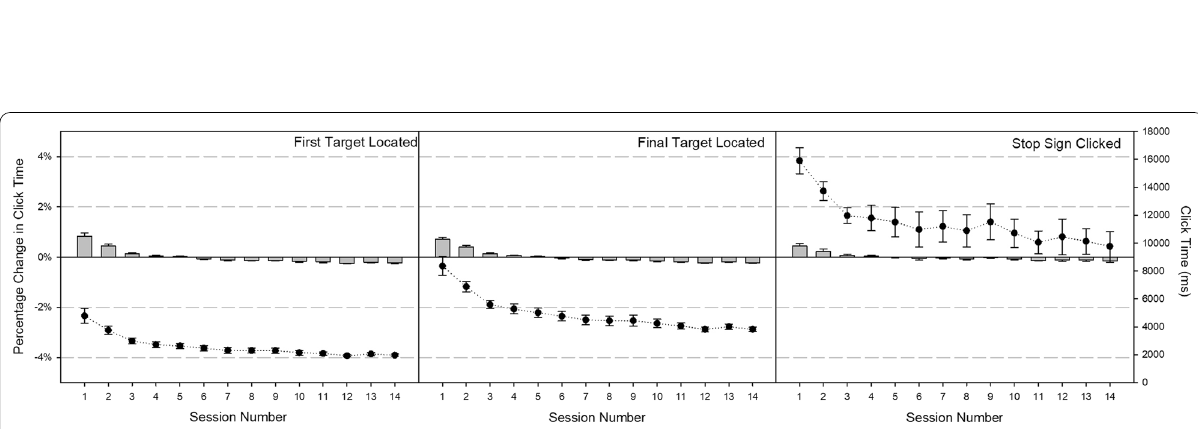
Fig. 15 Average raw (circles) and percent change (bars) click time RT across sessions for locating the first target (left panel), the final target (middle panel), and the trial-terminating stop sign (right panel). Error bars reflect